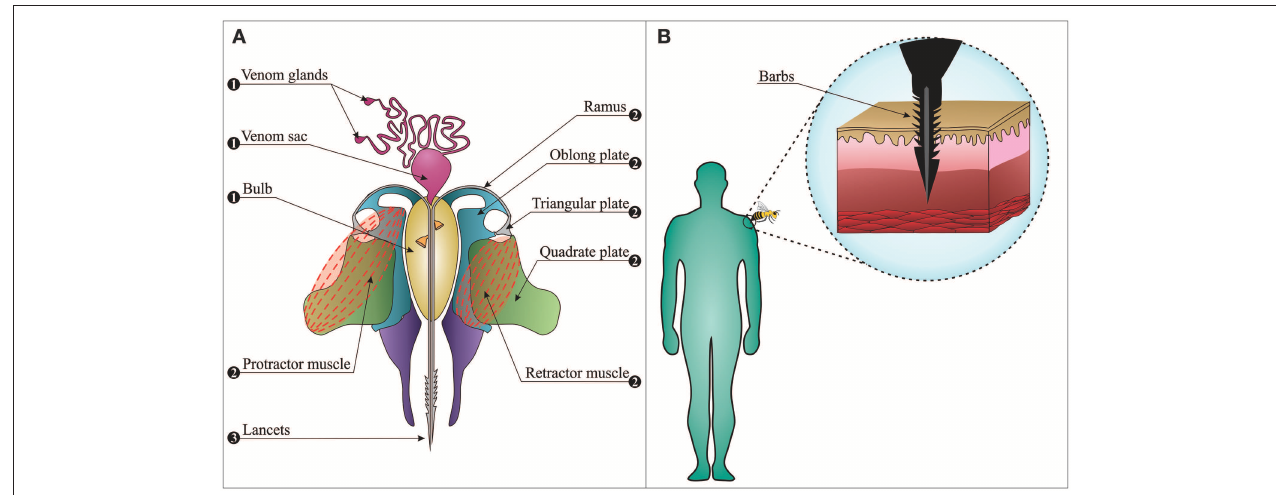
FIGURE 2 | The bee sting apparatus. (A) The venom apparatus consists of three functionally distinct parts: (1) The venom-related part is composed of a venom sac, two venom glands, and a bulb. (2) The motor part is composed of muscles, plates, and ramus on each side. (3) The piercing part is composed of two lancets and a stylet (note: the stylet cannot be observed in this figure since the longitudinal section has passed from the middle of the venom canal that leaves the stylet on the upper section). (B) Barbs anchor the stinger into the skin, from where the stinger cannot be retracted when the bee escapes (i.e., sting